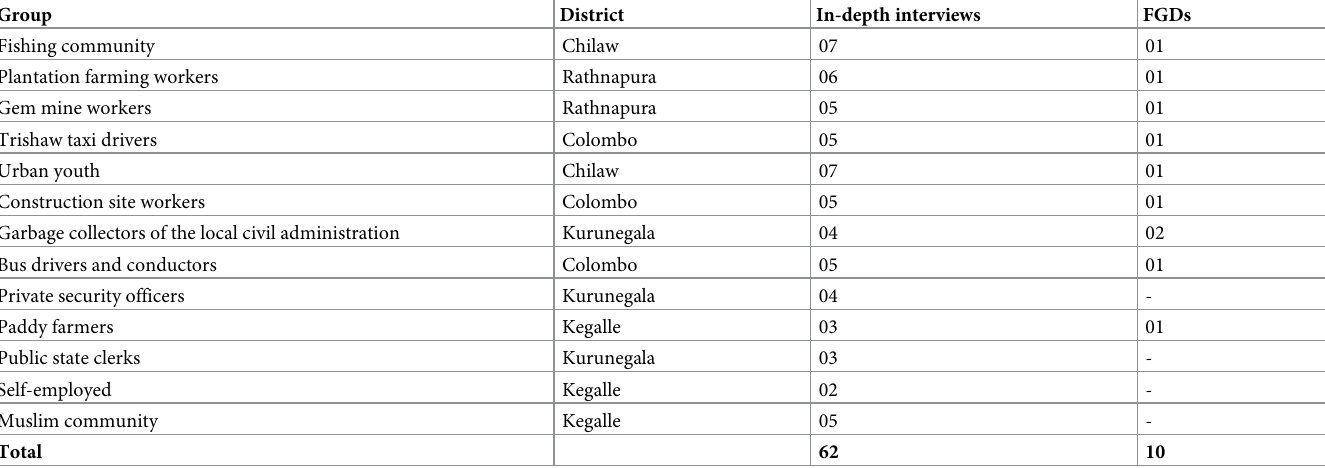
Table 1. Distribution of data collection sites and engaged